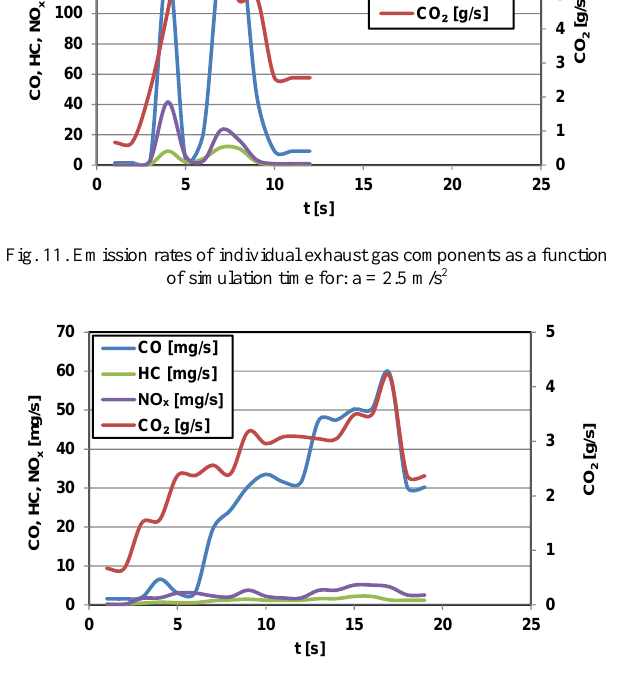
Fig. 12. Emission intensities of individual exhaust gas components as a function of simulation time for the acceleration mapped on the basis of the actual acceleration test